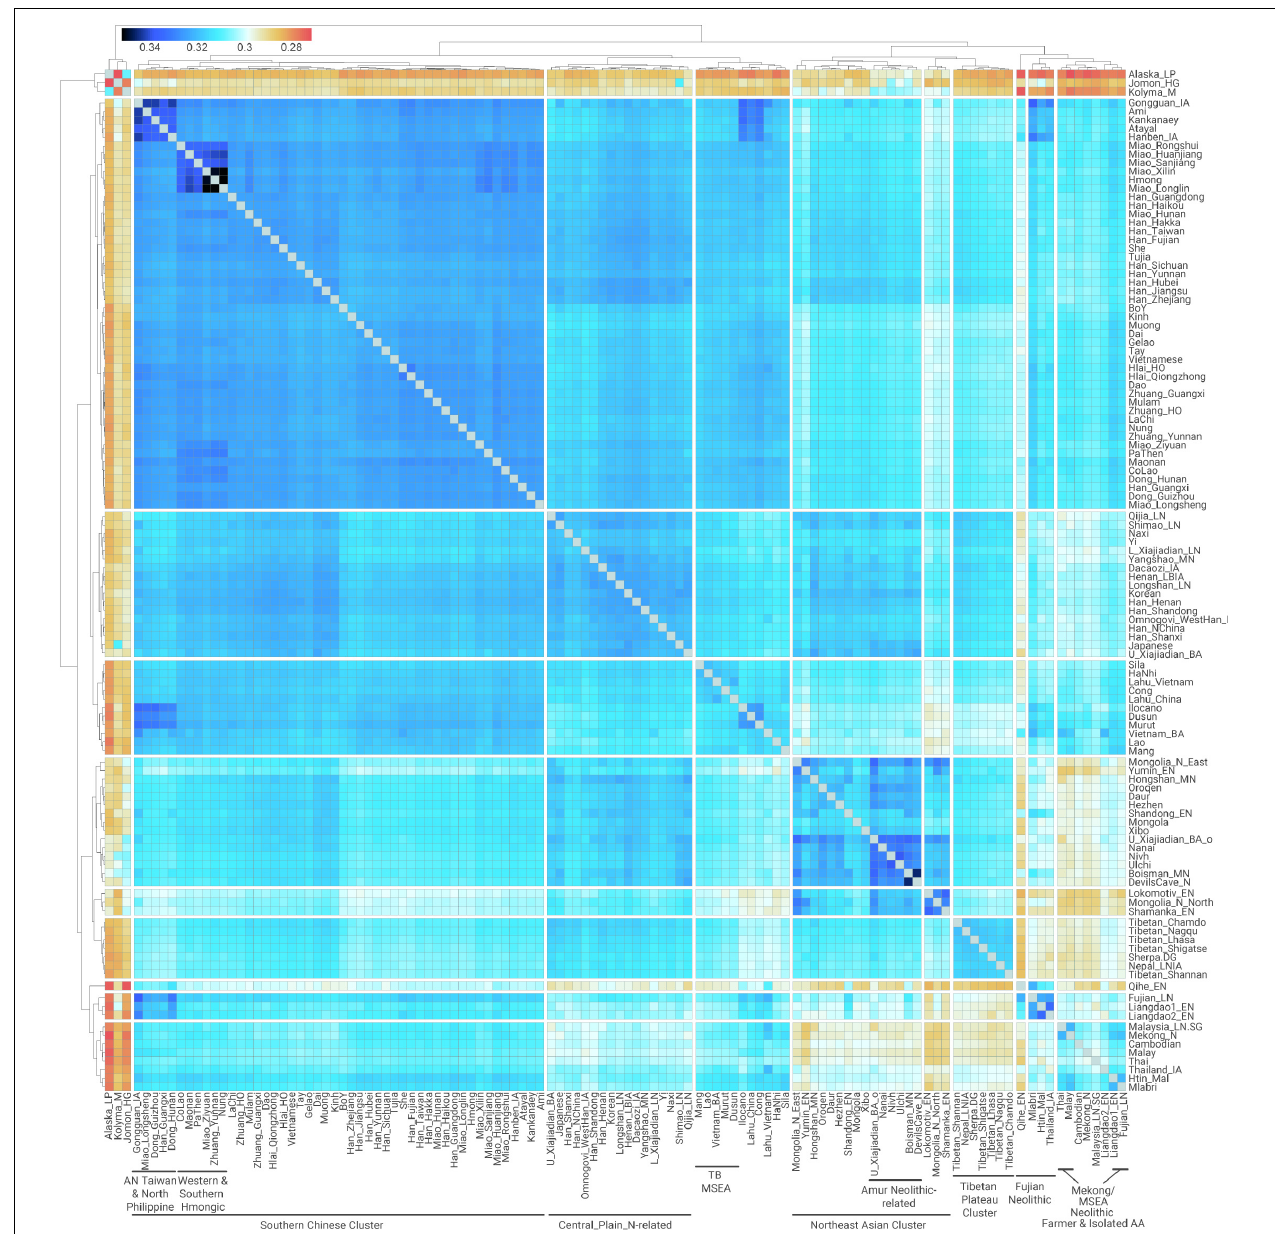
FIGURE 2 | Quantitative measurement for pairwise genetic affinity based on allele sharing. Outgroup- f 3 in the form f 3 (Mbuti; X, Y) measuring shared genetic drift between pairwise ancient and modern East Asian populations.